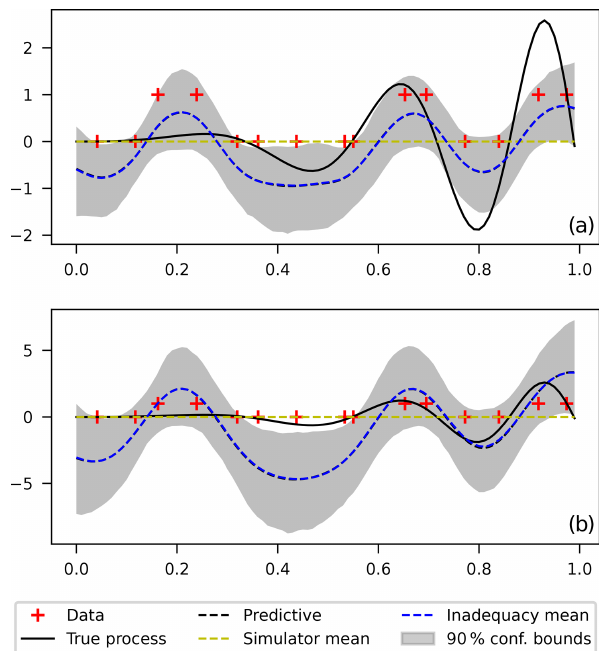
Figure 4. Calibration using the inadequacy function only for a θ 1 prior centered at 1 (a) and centered at 20 (b)